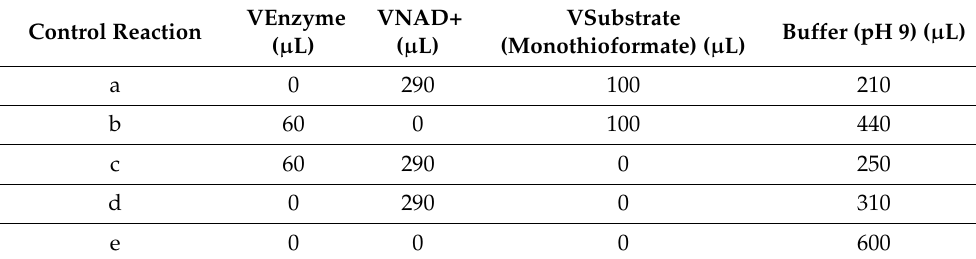
Table 4. Overview of sample composition for the control NMR